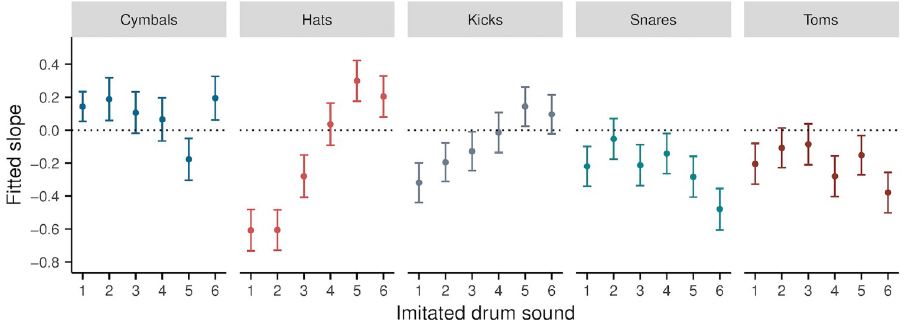
Fig 5. Slope estimates for the LMER model fitted using the distance measure from method PHG. A negative slope indicates a decrease in perceptual similarity with an increase in distance, i.e. sounds for which the method performs well. Values are mean estimates across all imitations for each drum sound, with 95% Wald confidence intervals.